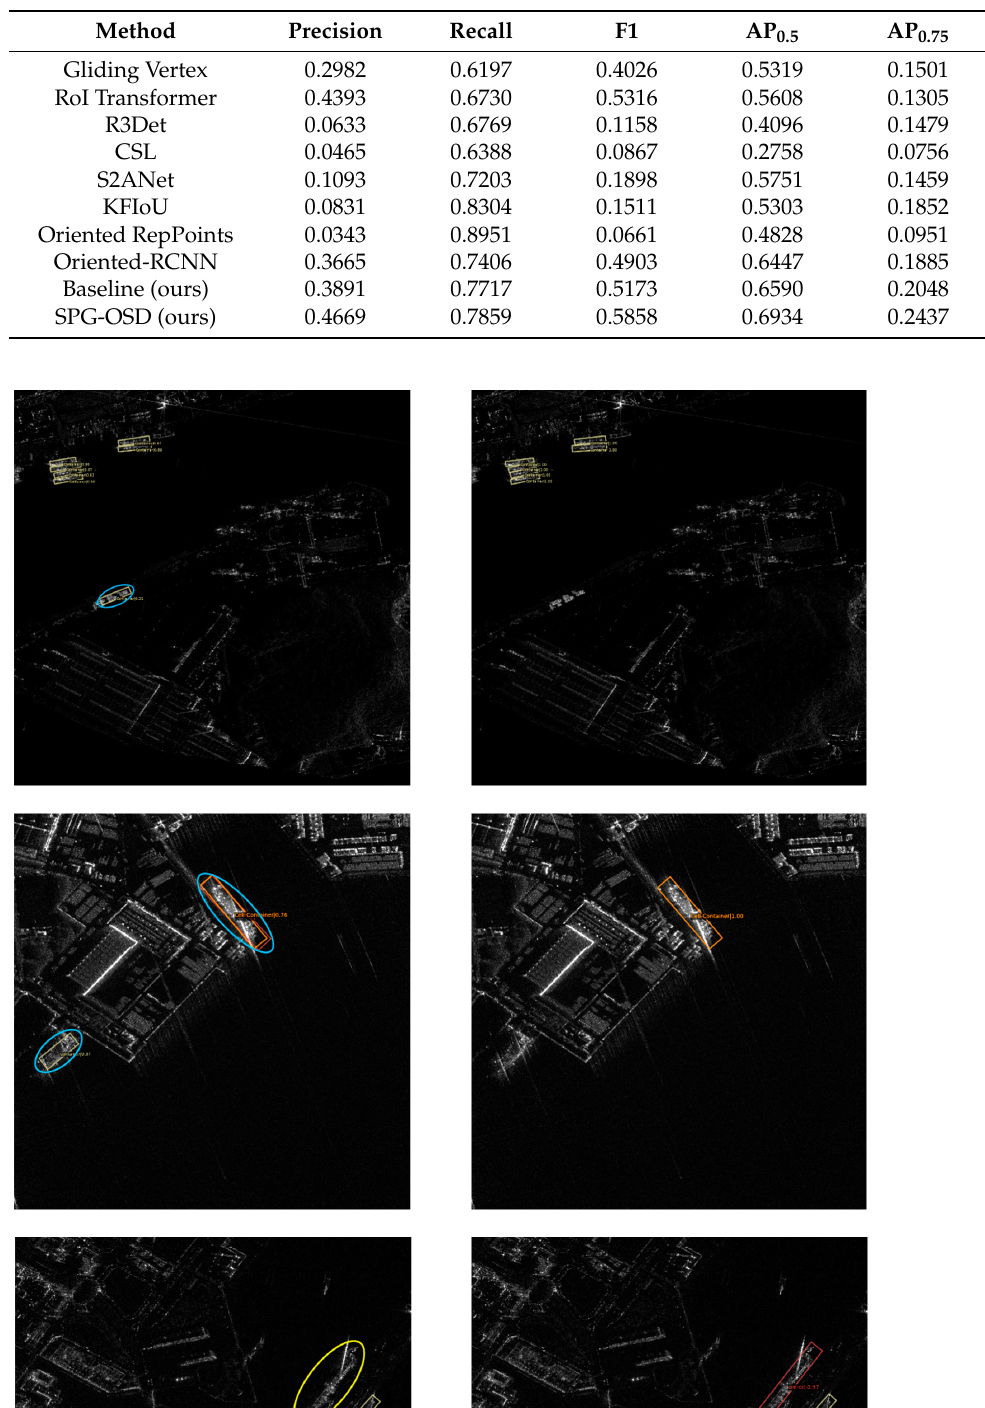
( b ) Figure 6. Comparison detection results of the Oriented-RCNN and our method. The yellow ellipses and blue ellipses represent the missing ships and false alarms, respectively. ( a ) Detection results of Oriented-RCNN. ( b ) Detection results of SPG-OSD.